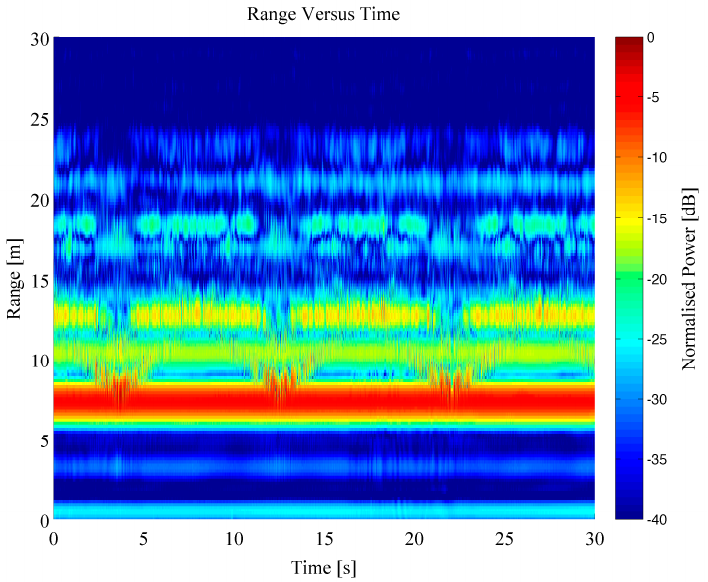
Figure 5. Range Time Intensity (RTI) plot of individual walking with free hands measured through the wall.